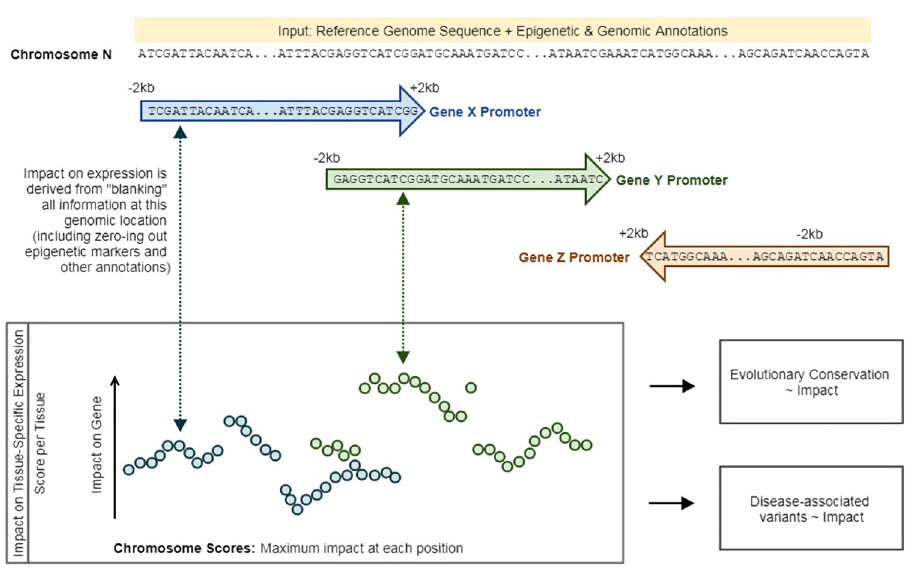
Fig 3. Schematic illustration of how the non-coding impact score was